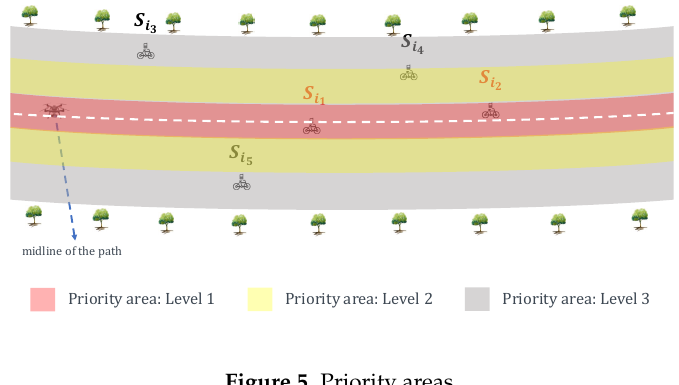
Figure 5. Priority areas. Algorithm 2 Prioritized-based contact-duration frame selection mechanism (PCdFS)